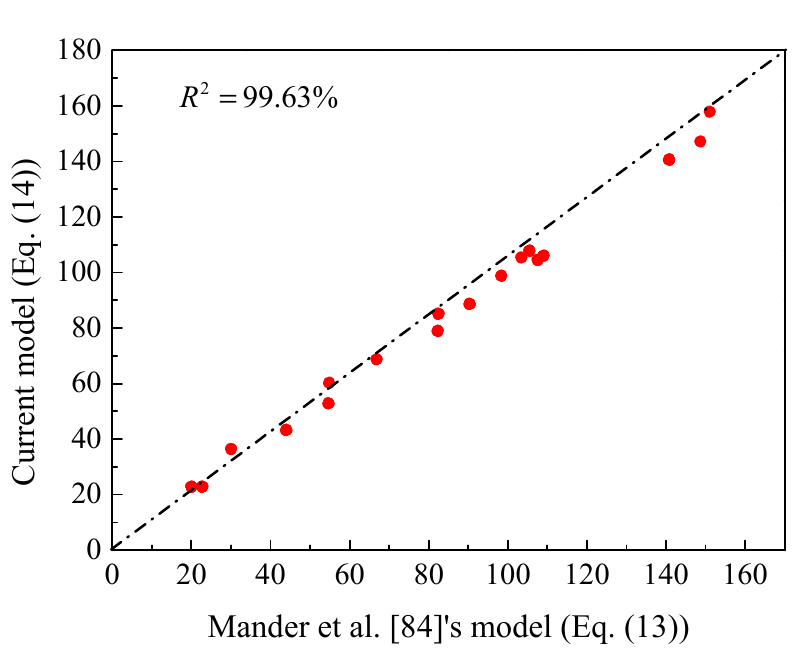
Figure 6. Correlation between the present confined strength model and that proposed by Mander et al. [92] for confined concrete.